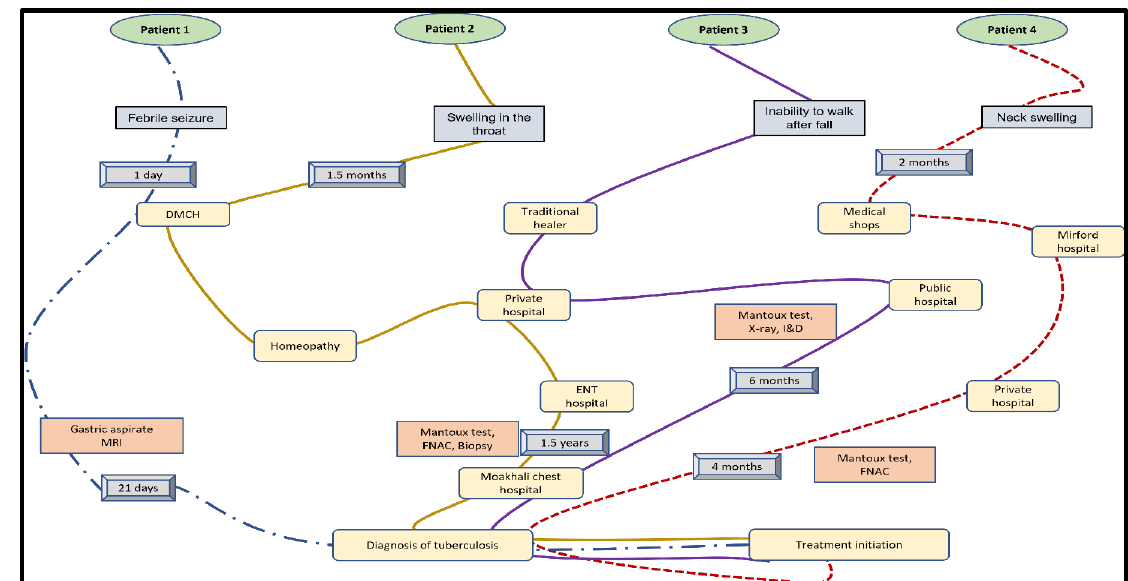
Figure 2. Pathway of diagnosis for four childhood TB cases. Child Friendly